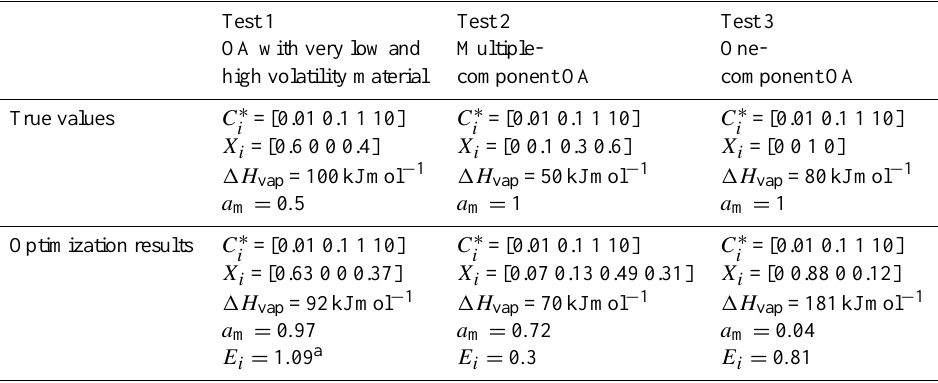
Table 1. Values of the true and estimated properties (volatility distribution, vaporization enthalpy, accommodation coefficient) for three OA examples.